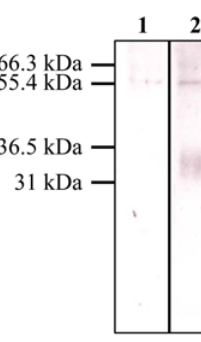
Figure 7. Western blot analysis of sera from repeatedly bitten rabbits. Five hundred nanograms of recombinant Ir-LBP were submitted to SDS-PAGE and analyzed by western blot using pooled serum from two naı¨ve rabbits (lane 1) and rabbits infested three times by I. ricinus female ticks (lane 2). *: unspecific band.